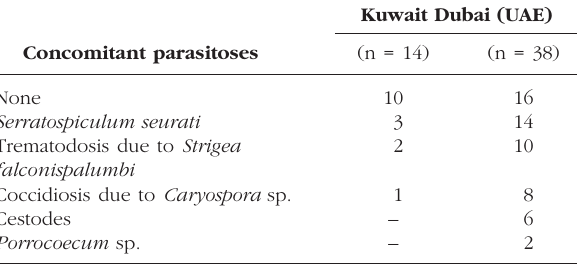
Table I. – Capillaria spp. infestation in falcons from Kuwait and Dubai.